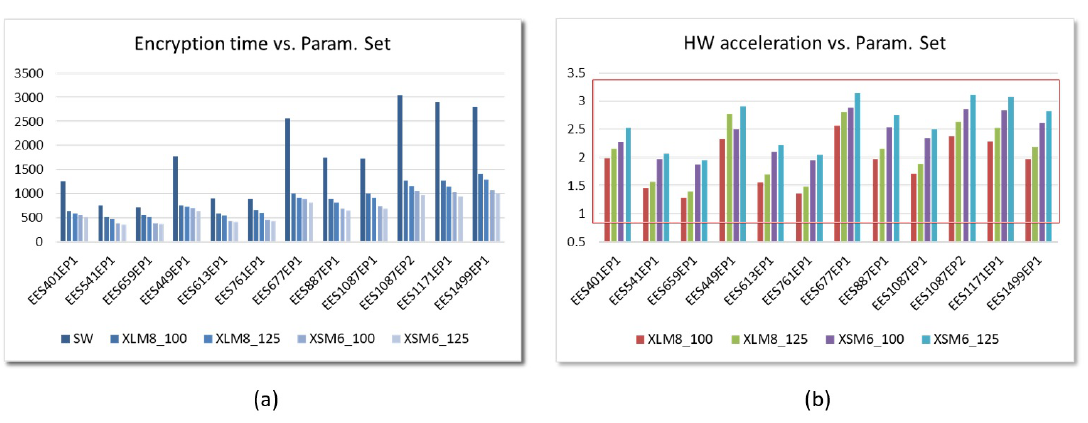
Figure 21. Times invested ( a ) and acceleration factors reached ( a ) in the encryption operation using the parameter sets defined in IEEE Std 1363.1 for SW and HW/SW embedded systems implemented on the Pynq-Z2 board (time displayed in µ s).